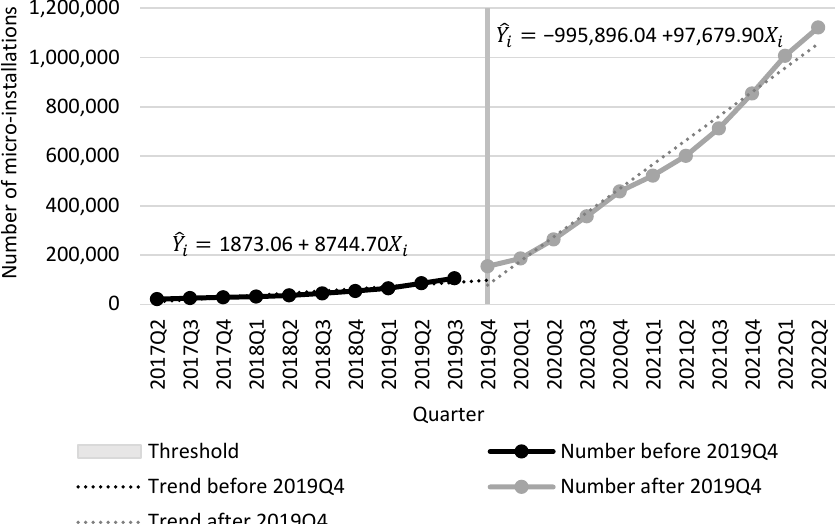
Figure 3. The regression discontinuity design models for the number of micro-installations in Poland.